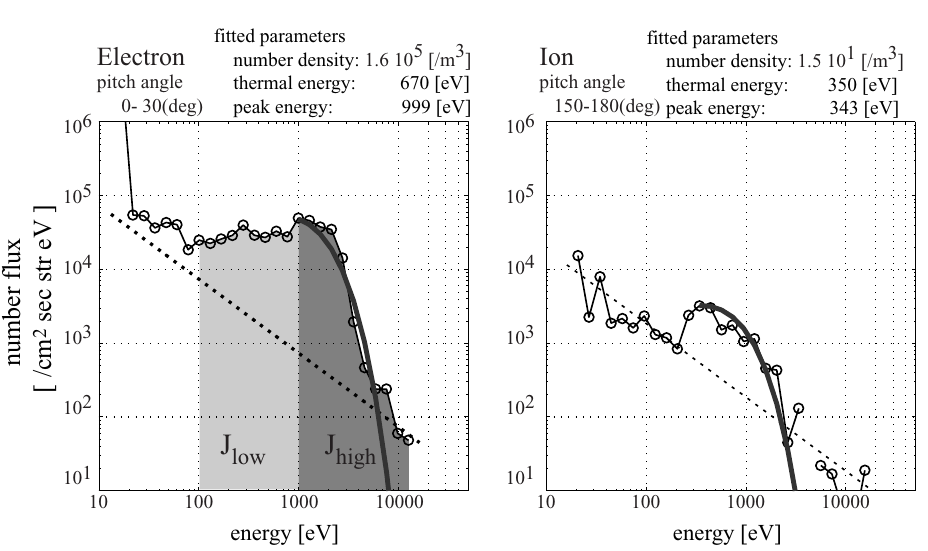
Fig. 2. Distribution functions of downward electrons and upward ions observed by Akebono/LEP in the particle acceleration region (repre- sented in dot). Solid curves represent the fitted accelerated Maxwellian distribution. Fitted parameters are also shown in each panel. The distribution function above E peak (dark hatched area) was integrated to calculate J high J low